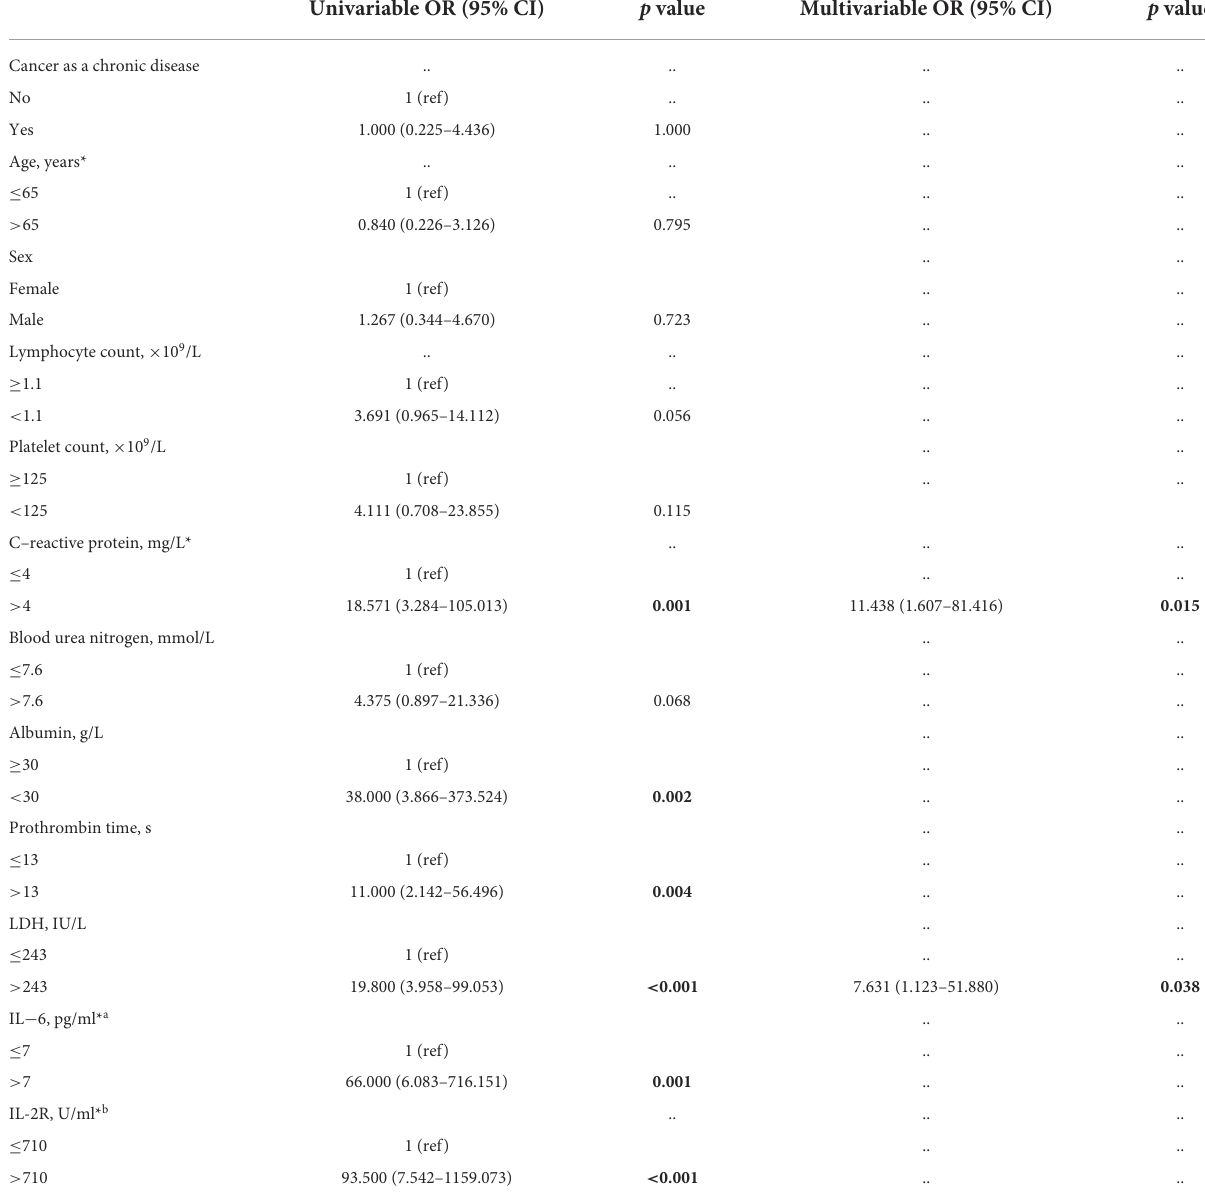
TABLE 5 Risk factors associated with severe events in COVID-19 patients with and without cancer. Univariable OR (95% CI) p value Multivariable OR (95% CI) p value Cancer as a chronic